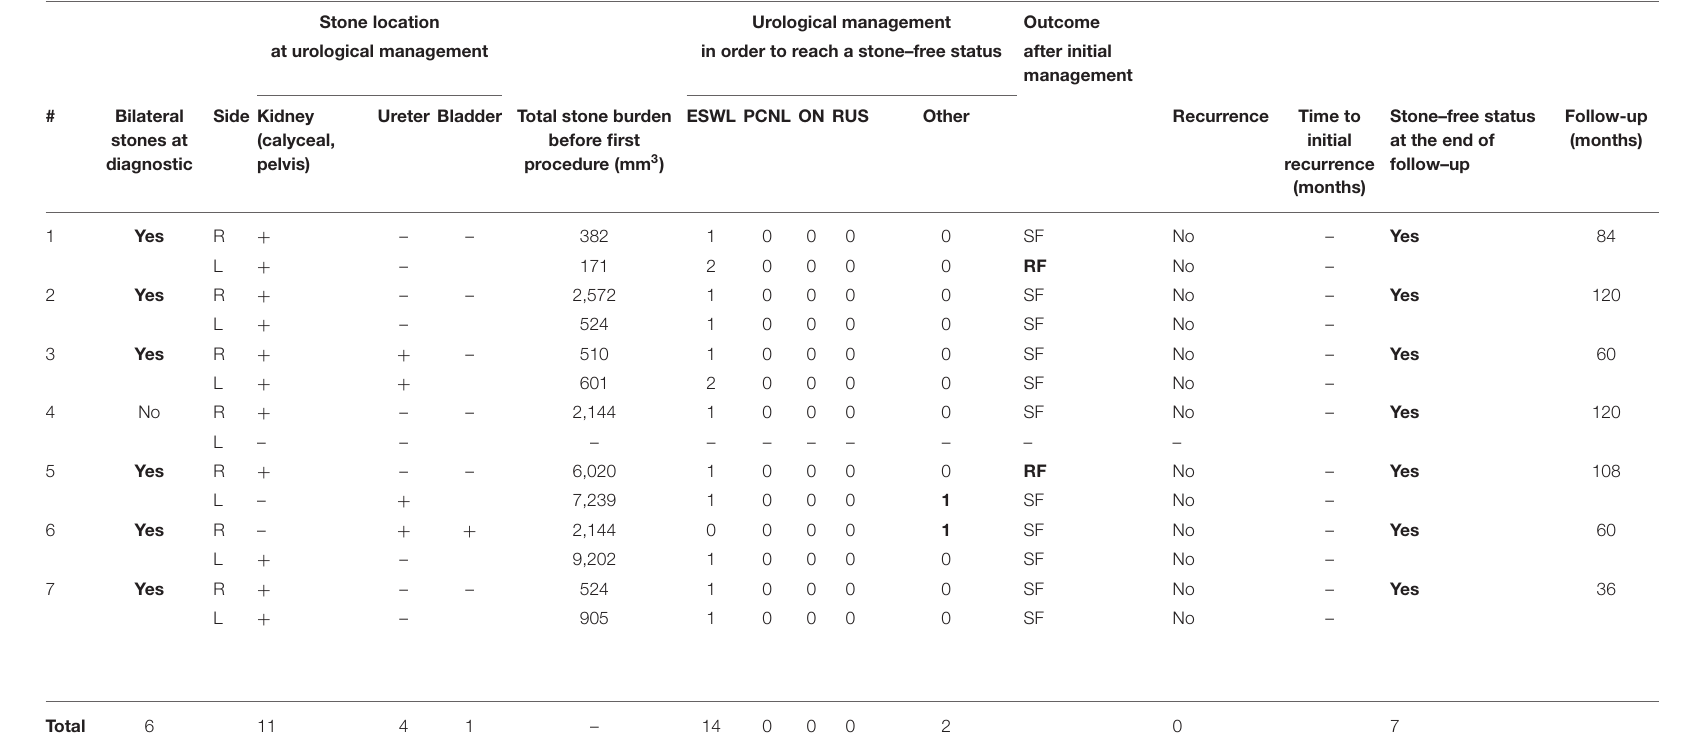
TABLE 2 | Results in group 1 (children younger than 2 years